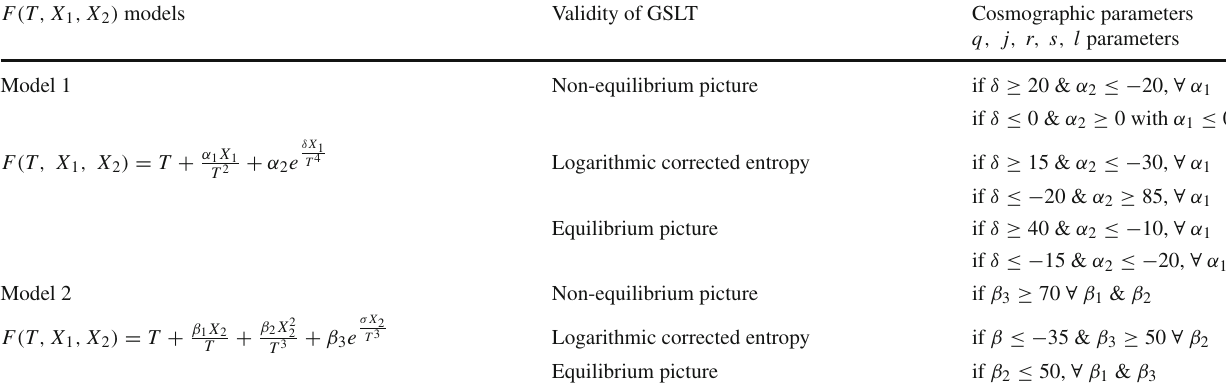
Table 1 Validity regions of F ( T , X 1 , X 2 )